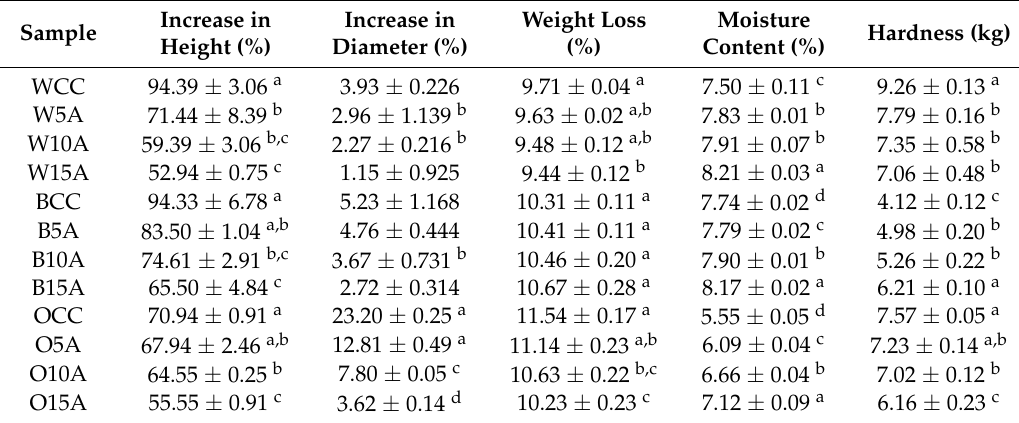
Table 2. Physical characteristics (after baking: changes in height (%), diameter (%) and weight loss (%); moisture content (%) and hardness (kg) of the model